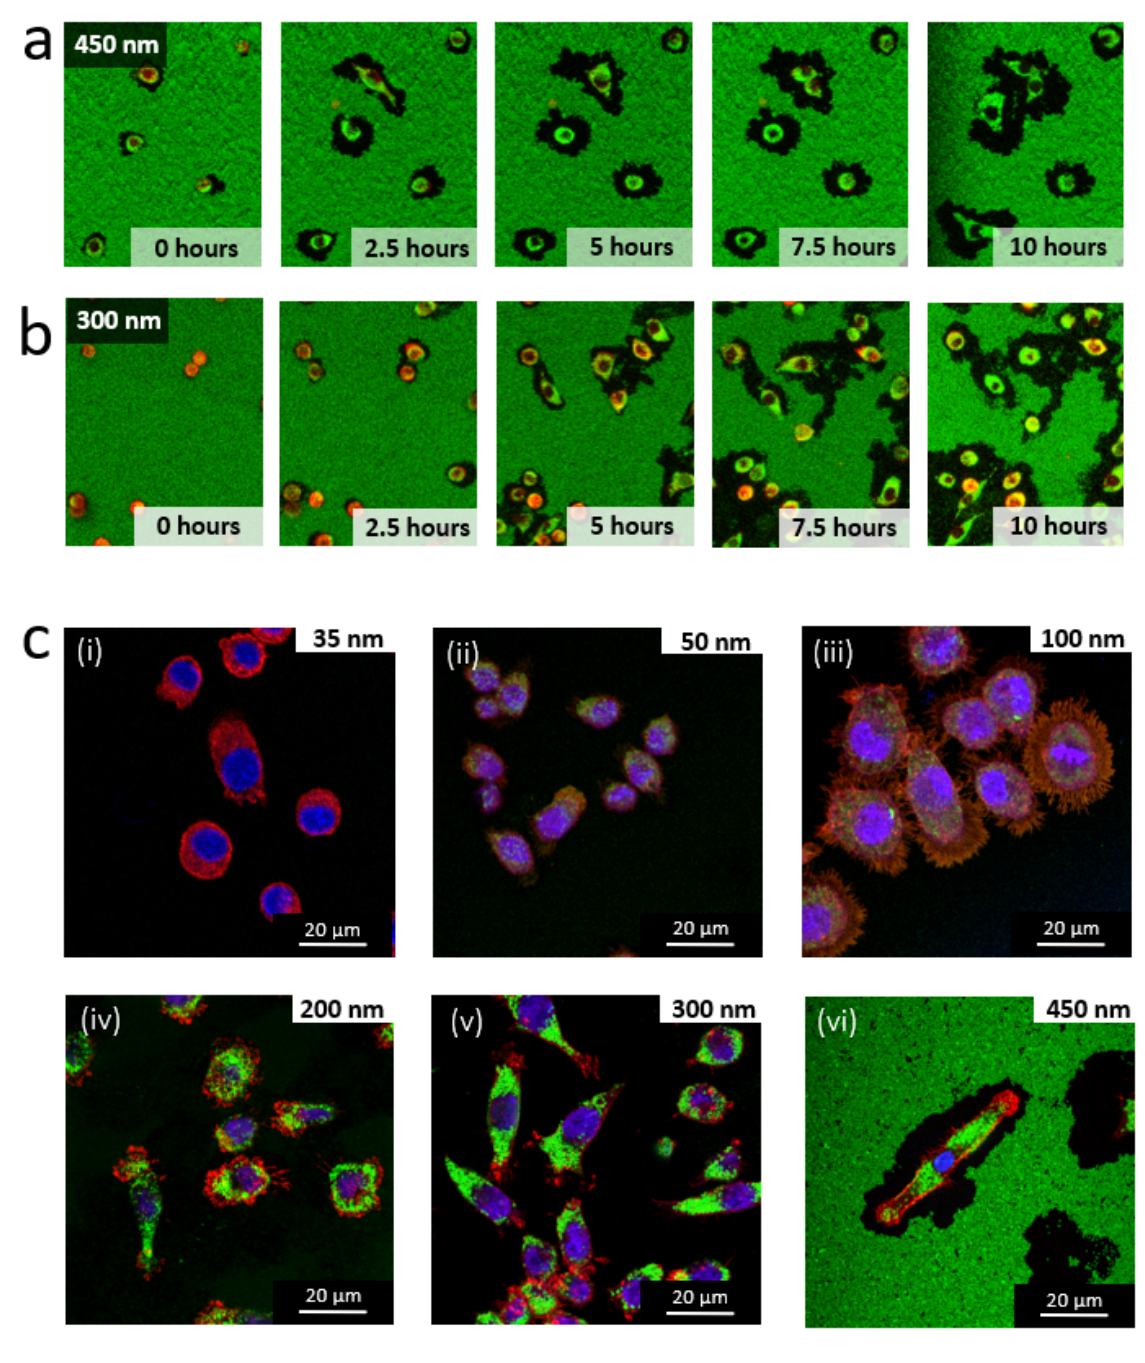
Figure 6. Nanoparticle-based monolayer damage and cellular internalization. ( a , b ) Sequence of confocal microscopy images of living RAW 264.7 macrophages adhering and migrating onto surfaces decorated with fluorescent silica NPs of ( a ) 450 nm NPs. ( b ) 300 nm NPs. NPs are shown in green, and membrane in red. ( c ) (i) to (vi) Confocal microscopy images of RAW 264.7 macrophages adhering to surfaces decorated with silica NPs: 35 nm (at 12 h), 50 nm (at 9 h), 100 nm (at 6 h), 200 nm (at 6 h), 300 nm (at 3 h) and 450 nm (at 3 h), respectively (fixed cells). NPs are shown in green, nucleus in blue and membrane in red. For a clearer view of the particles in the cell, only the best images from the confocal stack was chosen, thus excluding the adsorbed particles from the background (except for the 450